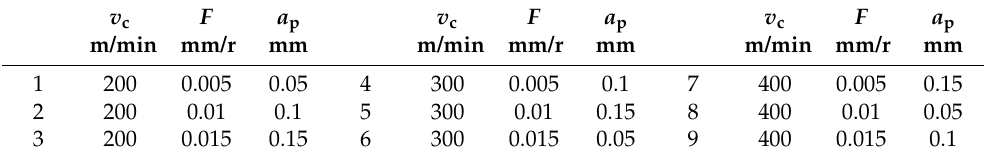
Table 1. Orthogonal experiments L 9 v c